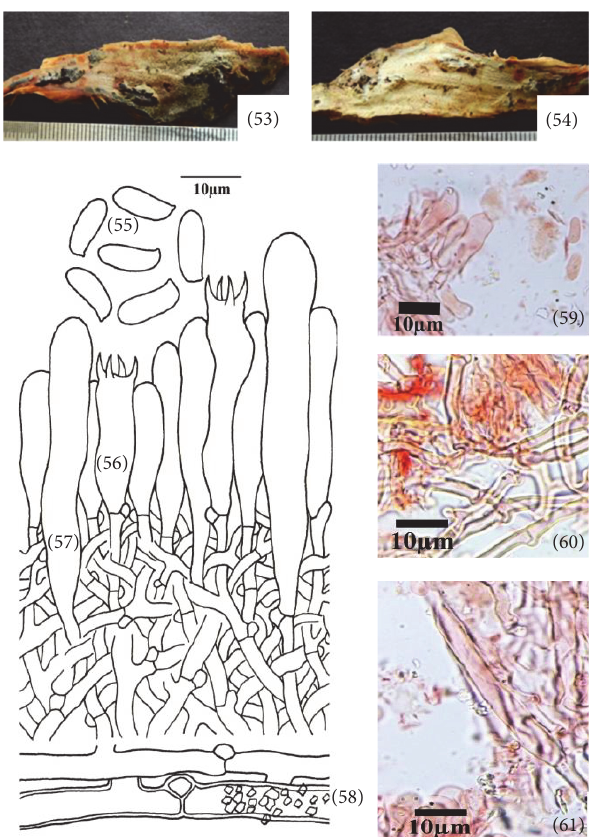
Figure 8: Hyphoderma transiens (53)–(61). (53) Fresh basidiocarp, (54) dried basidiocarp, (55) basidiospores, (56) basidium, (57) cystidium, (58) generative hyphae, (59) photomicrographs showing basidium and basidiospores, (60) photomicrographs showing generative hyphae, and (61) photomicrographs showing generative hyphae and